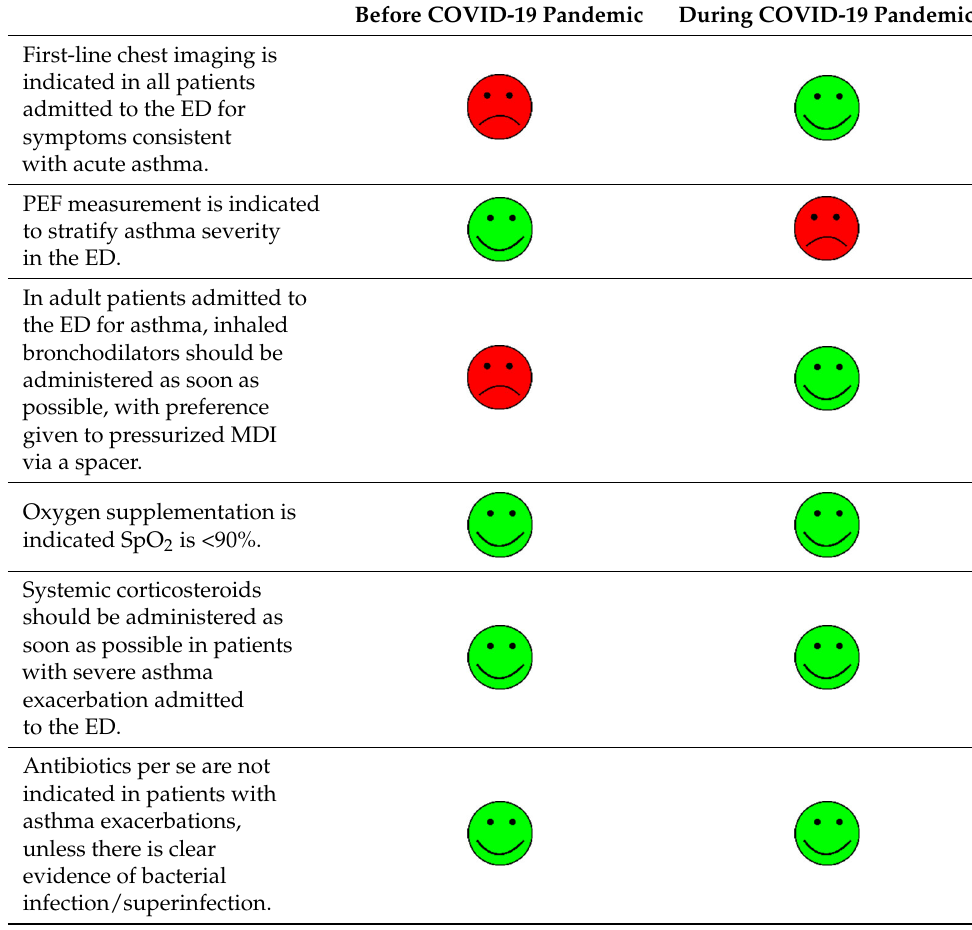
Table 1. Comparison of some major issues related to asthma management before and during COVID-19 pandemic in the emergency department (ED). Red face: expert opinion panel against; green face: expert opinion panel in favor. Abbreviations: MDI, pressurized metered dose inhaler; PEF, peak expiratory flow, SpO2, peripheral arterial oxygen saturation.